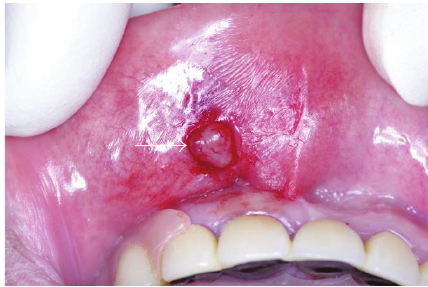
Figure 2: Intraoperative view. The mass had no adhesion and was excised with ease (arrow).